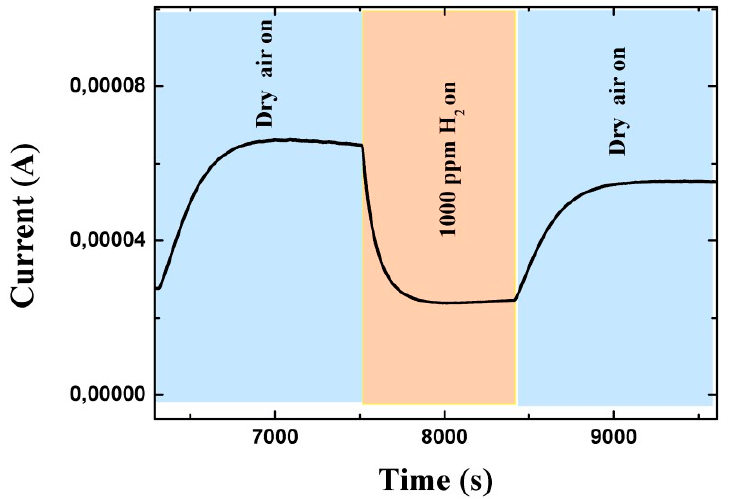
Figure 2. Dynamic sensor response of pristine CuO nanorods exposed to 1000 ppm H 2 .